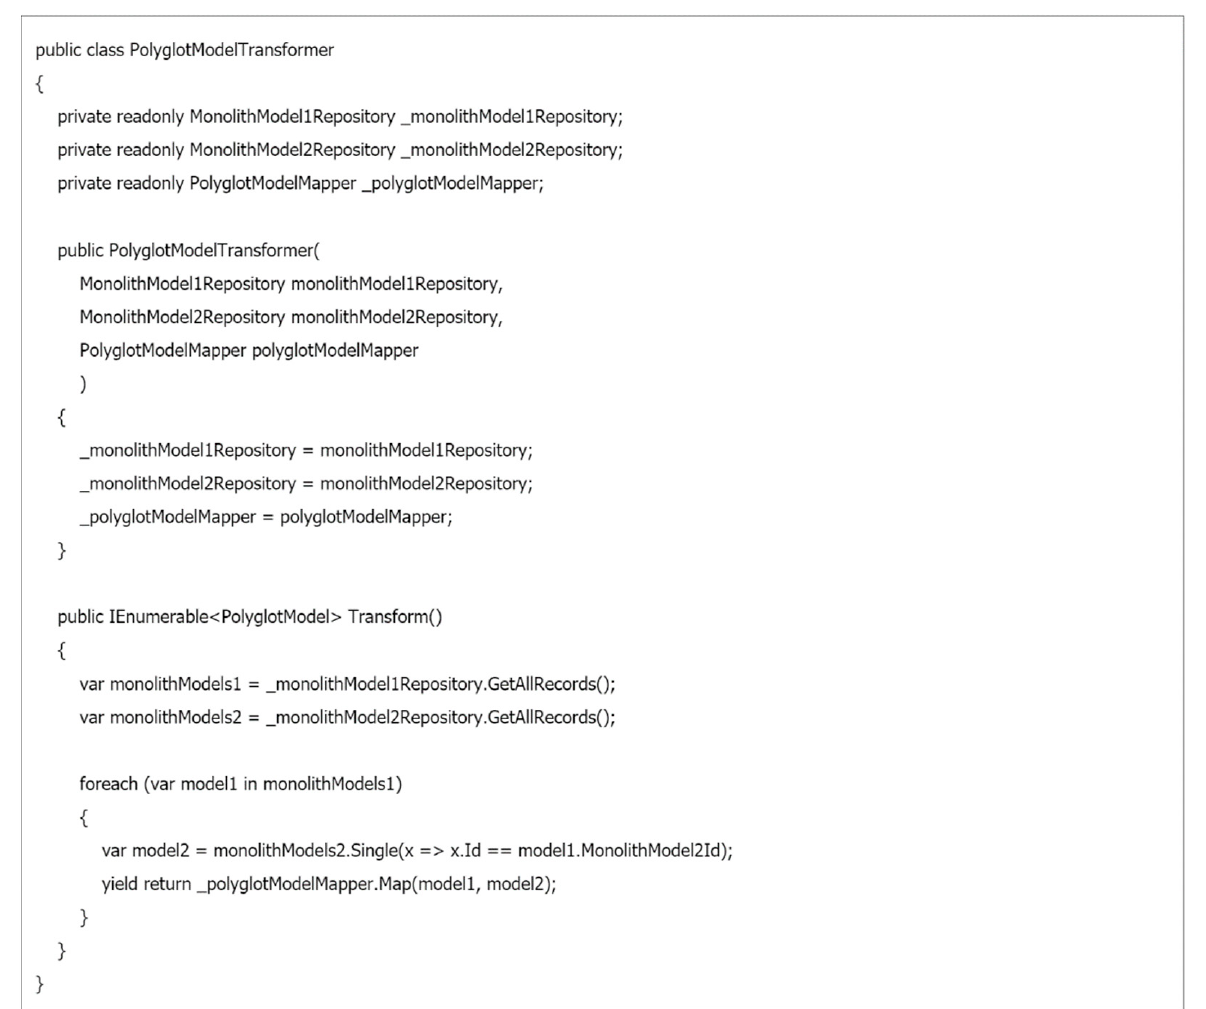
Figure 8. An example of the simplified record creation class.